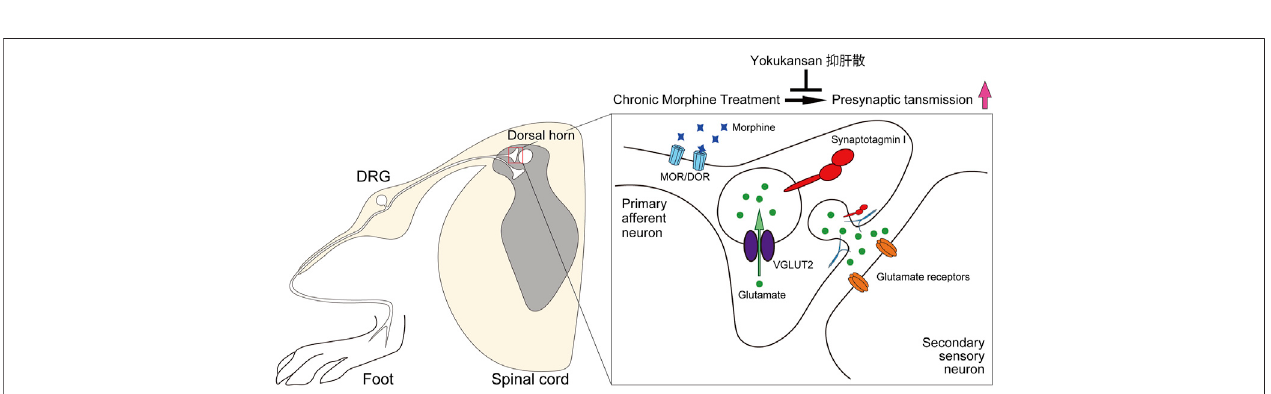
FIGURE 6 | Schematic illustration of the effect of YKS on the development of morphine antinociceptive tolerance. Continuous morphine administration would enhance of glutamatergic synaptic transmission between DRG neurons and the secondary neurons in the spinal cord dorsal horn via increasing presynaptic proteins without affecting postsynaptic functions during morphine tolerance formation. Pretreatment of YKS suppressed the potentiation and inhibited the development of morphine tolerance. DRG: dorsal root ganglion, MOR: μ -opioid receptor. DOR: δ -opioid receptor.